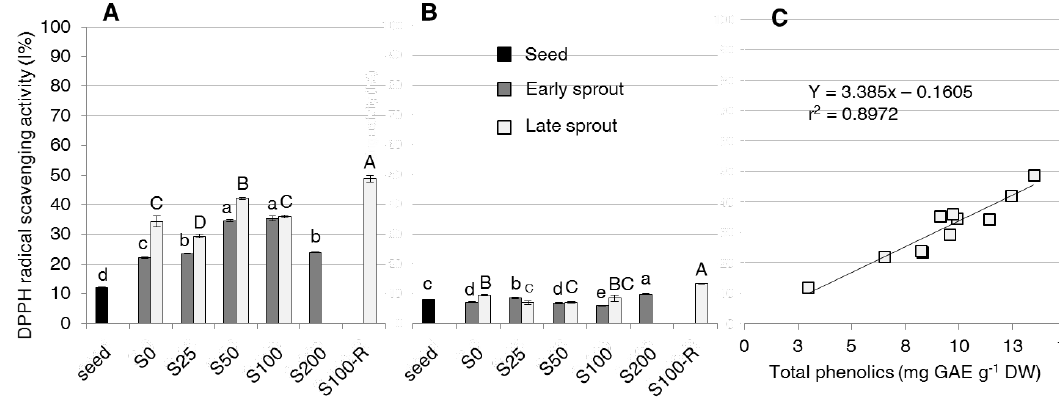
Figure 6. 2,2-Diphenyl-1-picrylhydrazyl (DPPH) radical scavenging activity (% inhibition of DPPH radical) of ( A ) free and ( B ) bound forms of phenolics, and ( C ) correlation between DPPH radical scavenging activity and content of the free form in seeds, early and late sprouts of rapeseed sprouted and grown with salt (NaCl) concentration 0, 25, 50, 100, 200 mM (S0, S25, S50, S100, S200, respectively) or sprouted with 100 mM and then grown with distilled water as recovery treatment (S100-R). Average values of duplicate determinations ± standard error are depicted. Different letters within each graph indicate statistically significant differences at p = 0.05 (Fisher’s LSD). Lower case letters are for comparison within early sprouts; upper case letters for comparison within late sprouts.